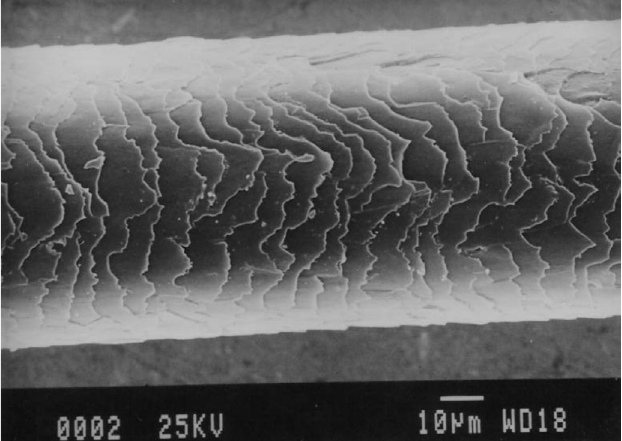
FIGURE 1 - SEM photomicrograph of an Afro-Ethnic hair